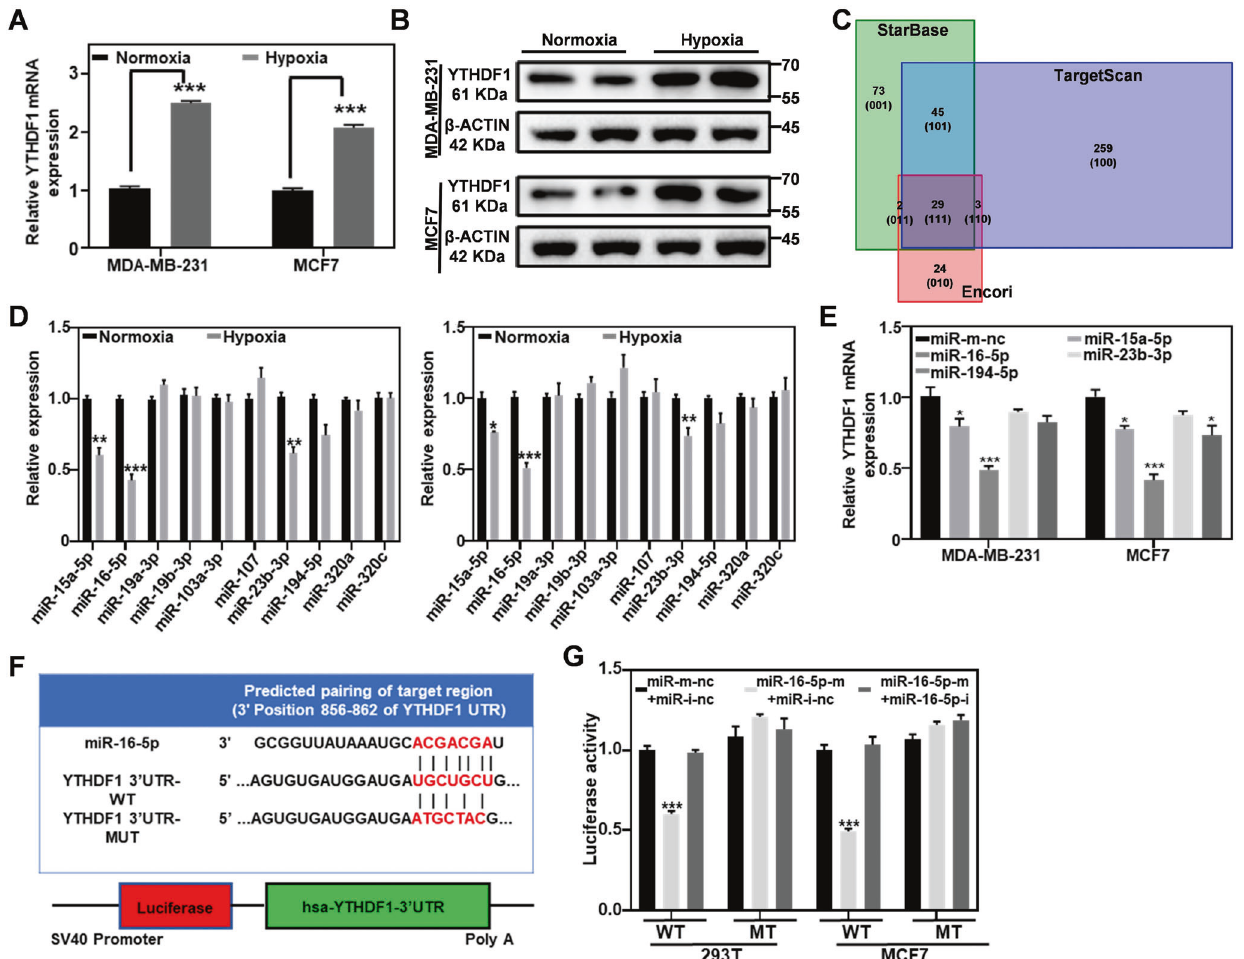
Fig. S4C, D, I, and J). Flow cytometric analysis based on Annexin V/ PI staining further suggested that the transfection of